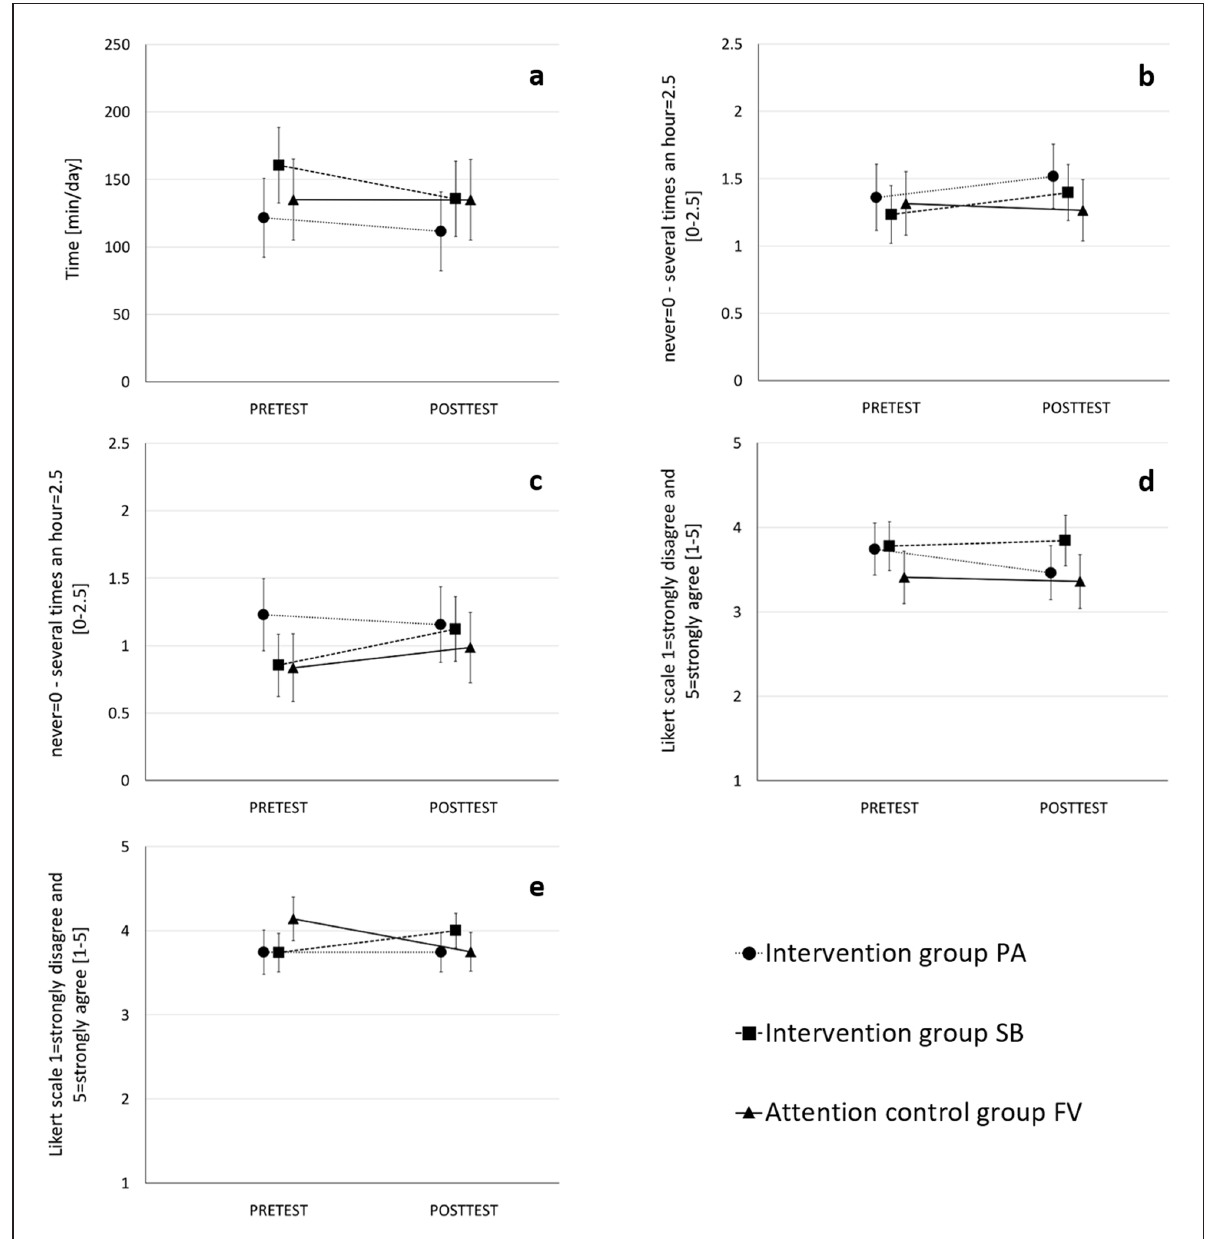
Figure 3 Pre- and posttest means and 95%-Confidence Intervals of the SB variables. a Minutes of leisure screen time per day. b Quantity of active breaks. c Quantity of standing time. d Intention of screen time reduction. e Intention to do active breaks (p < .05). Note that means and CIs are shifted left/right in order to make it more